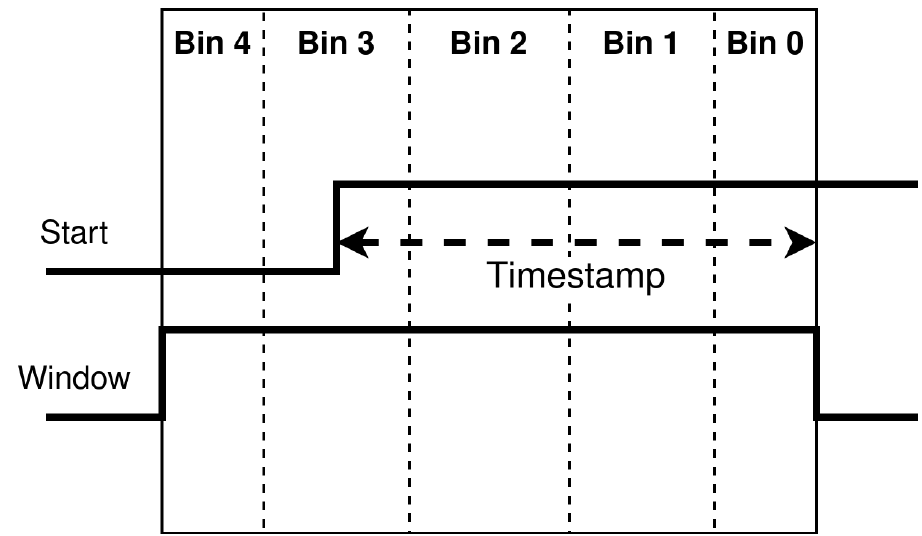
Figure 4. Using the TDC gating and programmable boundaries, on-chip processing can categorize events into which time-bin they belong. The timestamp is relative to the window instead of the system